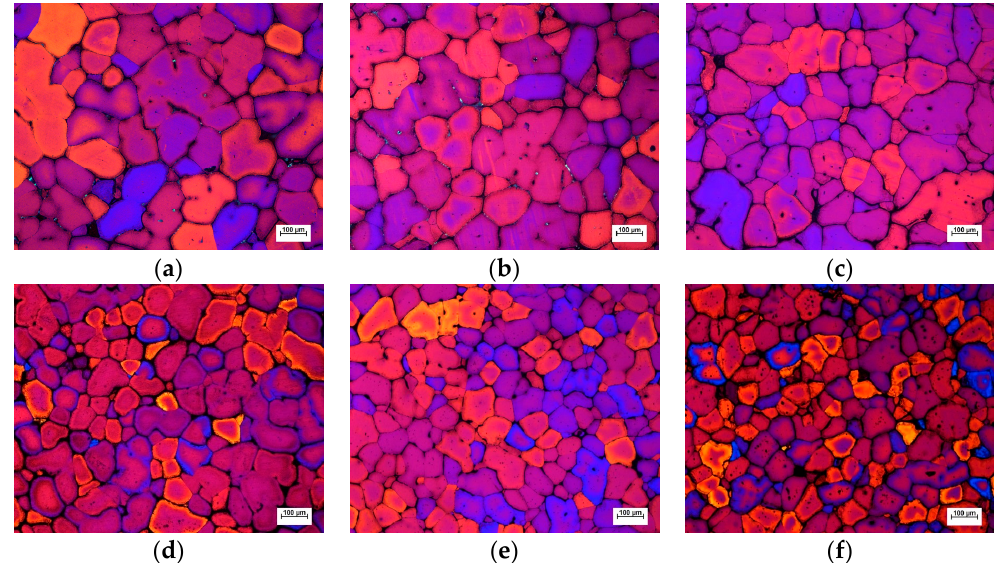
Figure 13. The microstructure of the disk pieces treated by AEMS and M-AEMS with the pouring temperature of 910 K at different sampling locations: ( a ) M 1 , AEMS; ( b ) M 2 , AEMS; ( c ) M 3 , AEMS; ( d ) M 1 , M-AEMS; ( e ) M 2 , M-AEMS; ( f ) M 3 , M-AEMS.